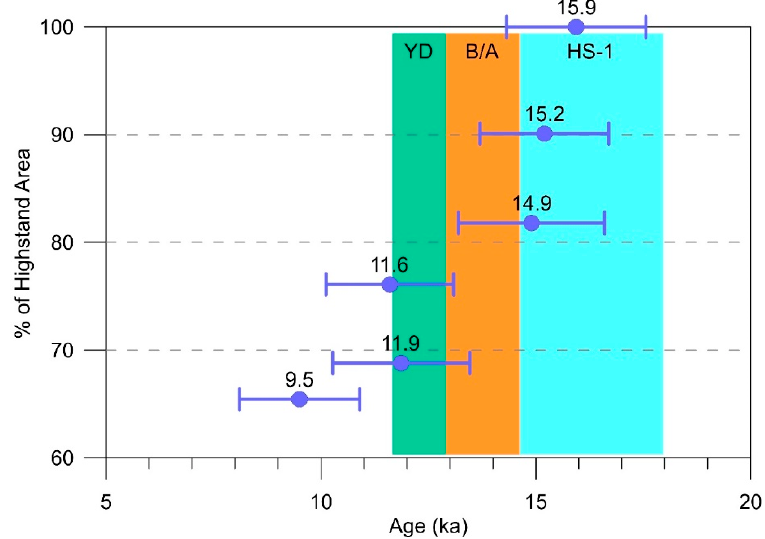
Figure 13. Luminescence-based chronology for the regression of Lake Clover. The lake reached its highstand ca. 16 ka during Heinrich Stadial I (HS-1), regressed leading into the Bølling / Allerød (B / A), built additional shorelines during or at the end of the Younger Dryas episode (YD), and constructed a final shoreline early in the Holocene after losing ~35% of its highstand